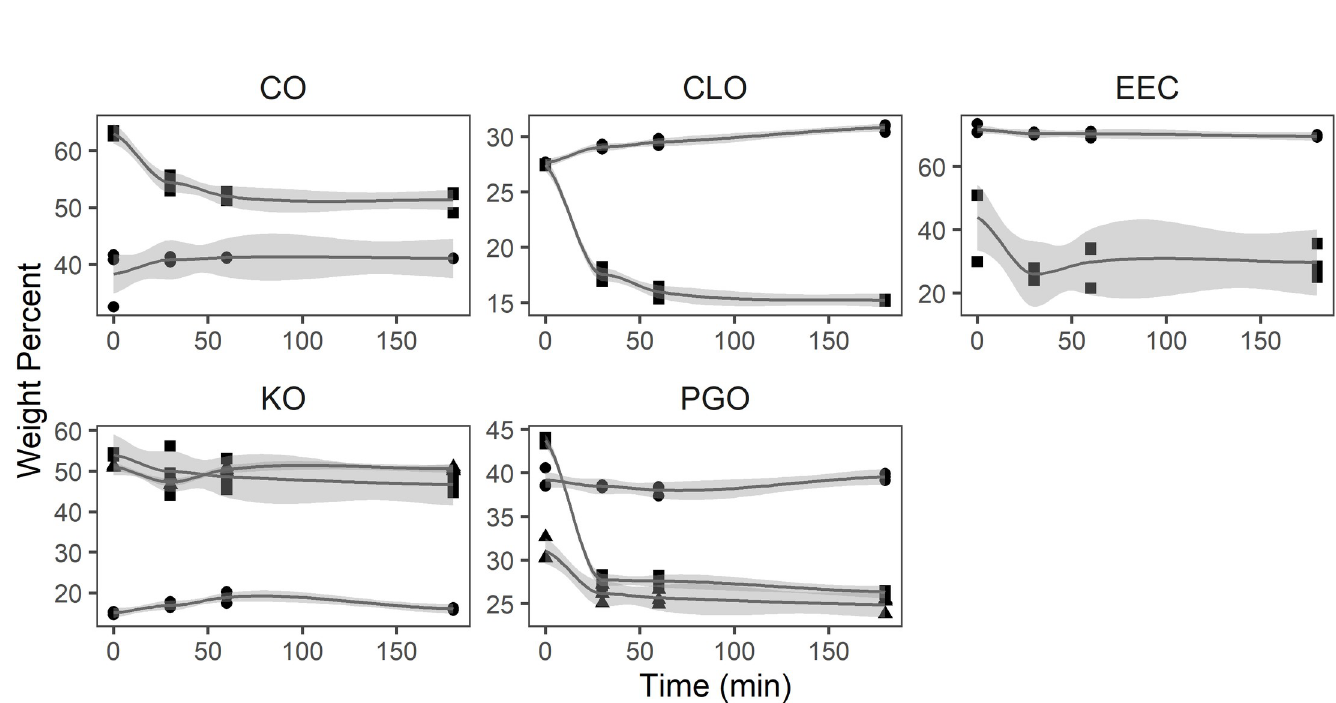
Fig 6. Amount of omega-3 fatty acids (weight percent) in free fatty acid (square), neutral lipid (circle) and polar lipid (triangle) fraction of samples from Calanus 1 oil (CO), cod-liver oil (CLO), ethyl ester concentrate (EEC), krill oil (KO) and oil from Porosira glacialis (PGO) (n = 3) during in vitro digestion.